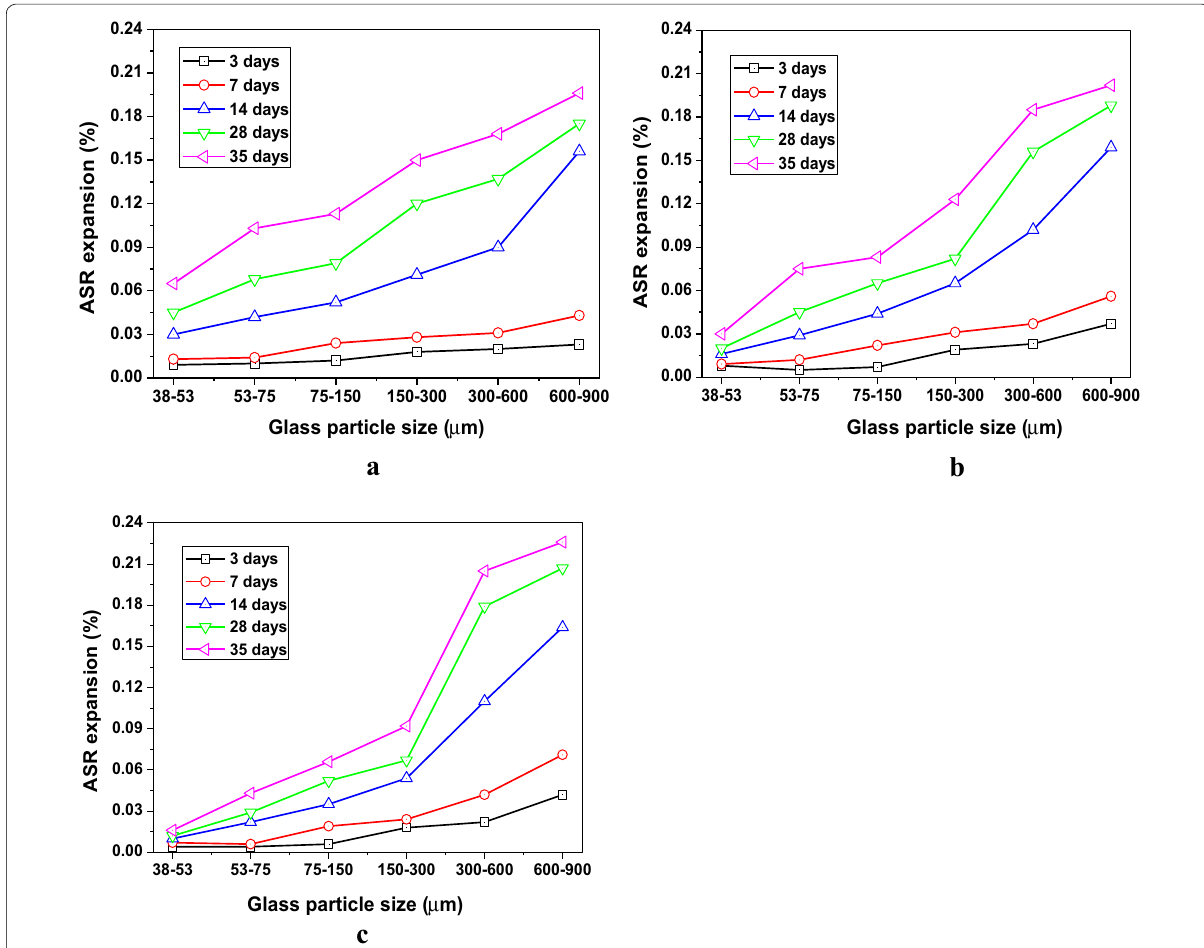
Fig. 2 Effect of the particle sizes of glass powder on ASR expansion of cement mortar bars at different replacement ratios. a Replacement ratio of 10%, b replacement ratio of 20%, c replacement ratio of